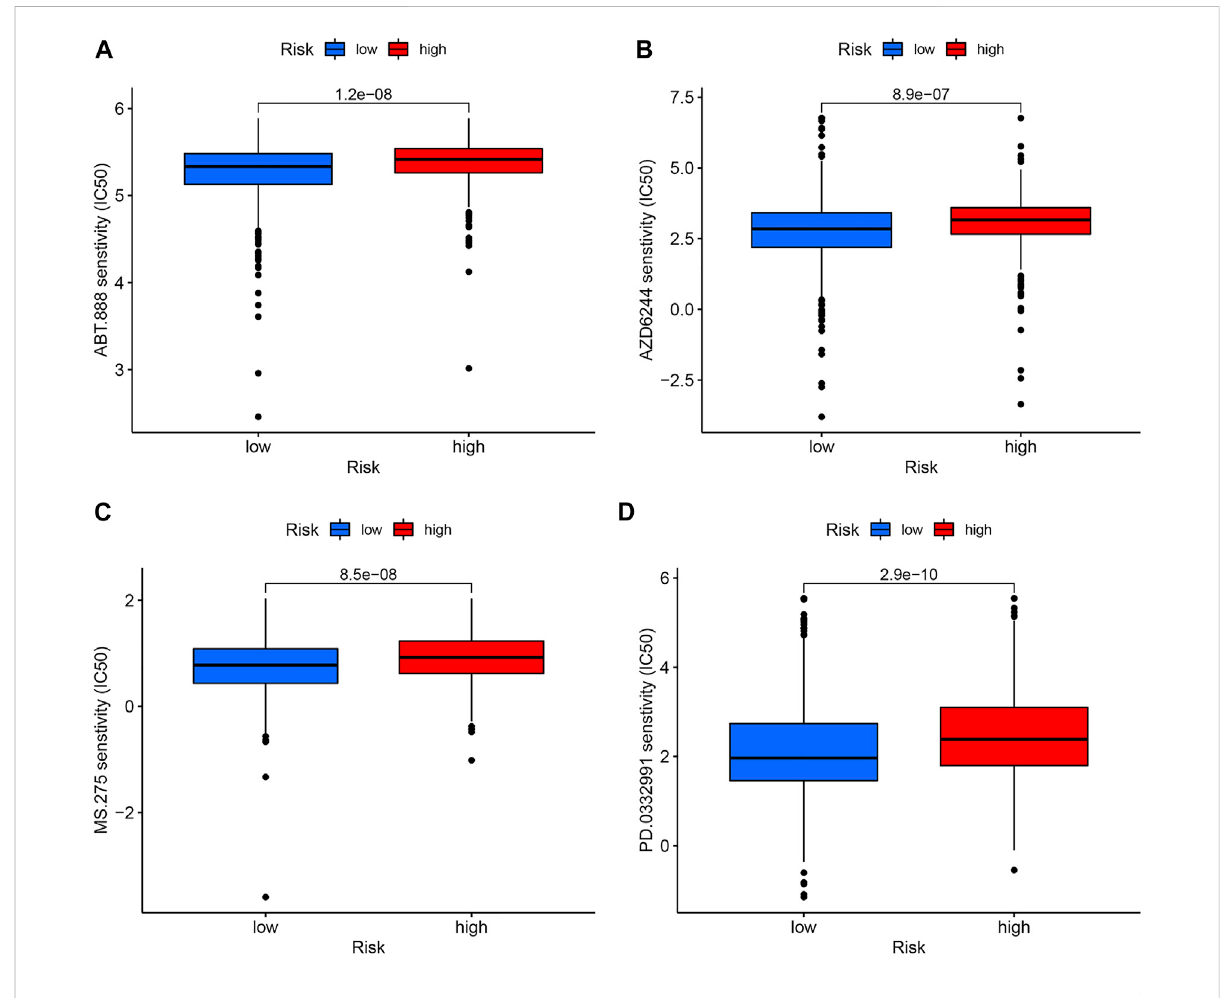
FIGURE 8 Drug sensitivity analysis. The candidates are Veliparib (A) , Selumetinib (B) , Entinostat (C) , and Palbociclib (D)